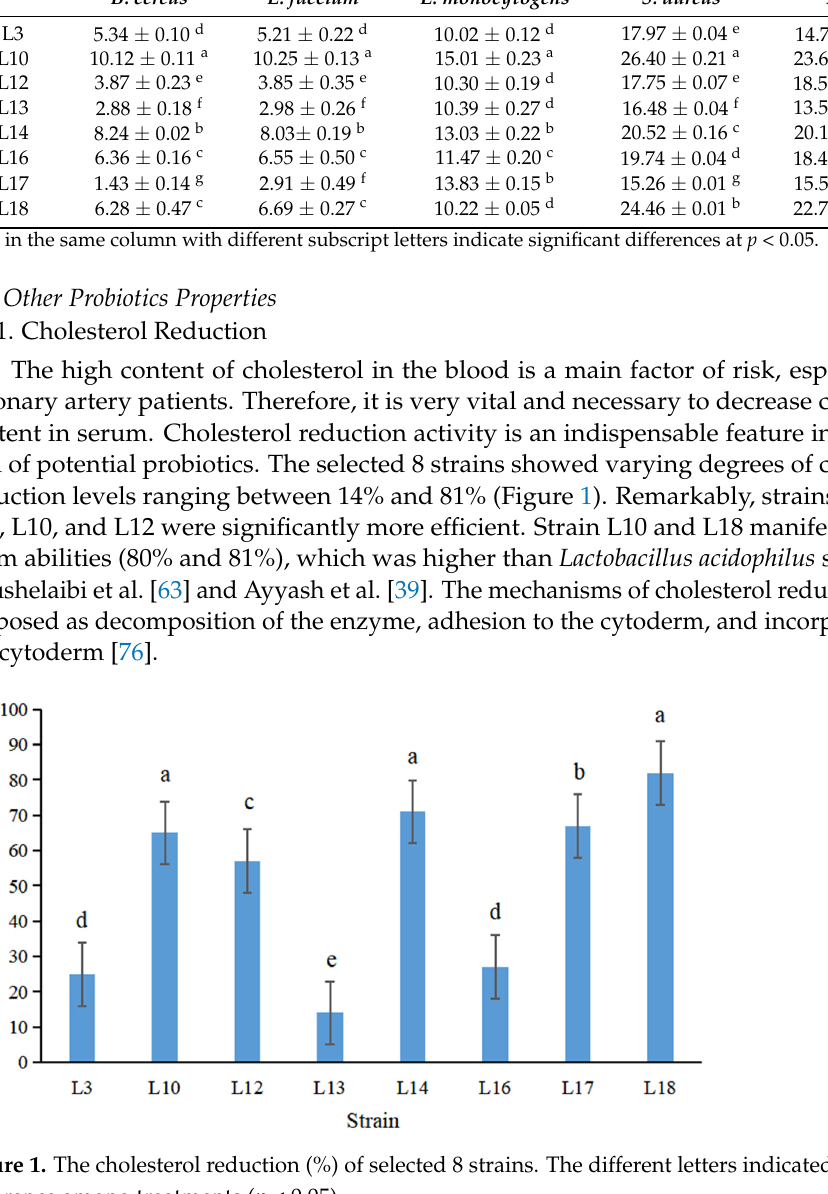
Table 4. Antibacterial activity of cell-free supernatants (CFS) of selected 8 strains. Inhibition Zone Diameter (mm) Strains G + Bacteria G − Bacteria B. cereus E. faecium L. monocytogens S. aureus E. coli